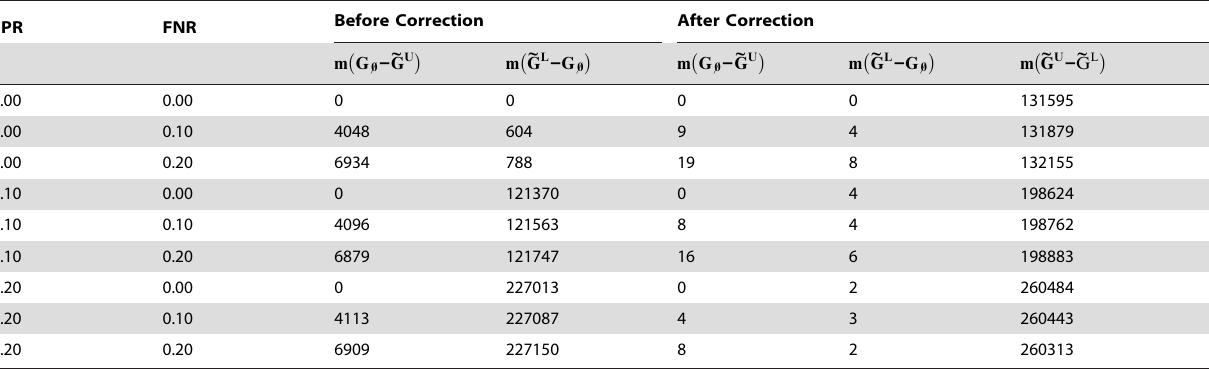
FPR Before Correction